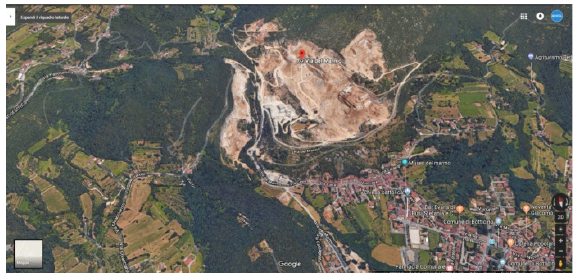
Figure 2: Aerial view of the Botticino site (Courtesy of Google ®